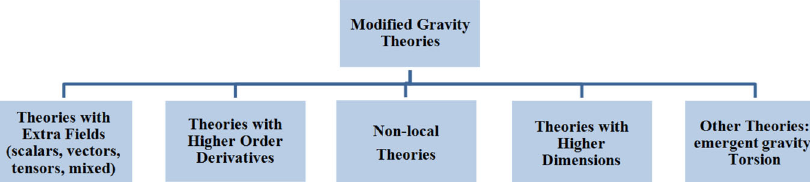
Fig.11 Various categories of modified gravity (MG) theories according to the principle or requirement they violate. It is worth noting that some models can belong to more than one category here like for example some higher dimensional models that have extra fields dimensions, (iv) non-locality or violation of Lorentz-invariance, see Fig. 11.